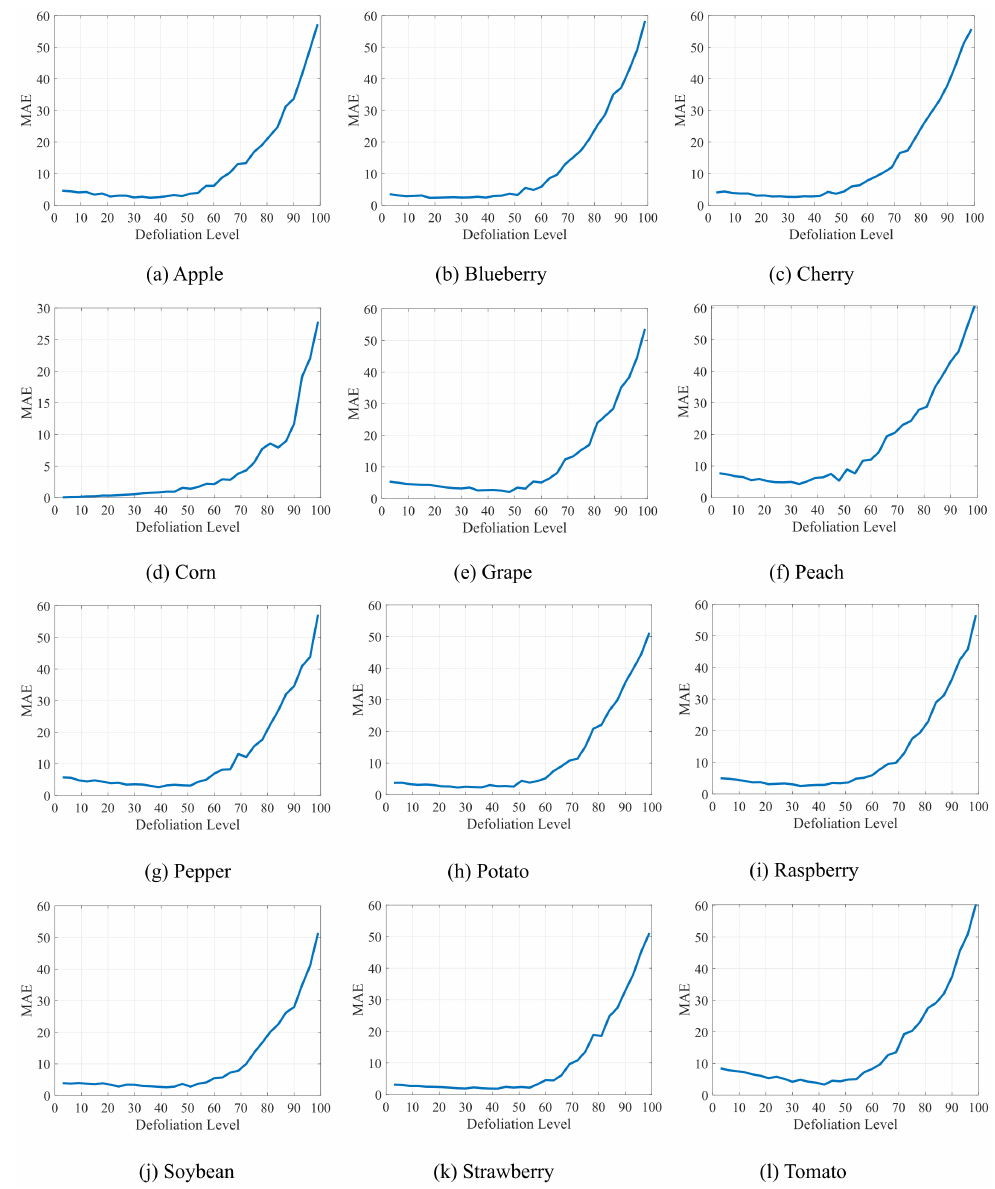
Figure 3. Results of our method concerning different levels of